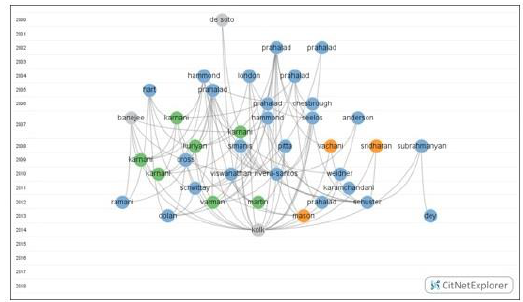
Figure 7. Publication citations networks (frequency >= 10)